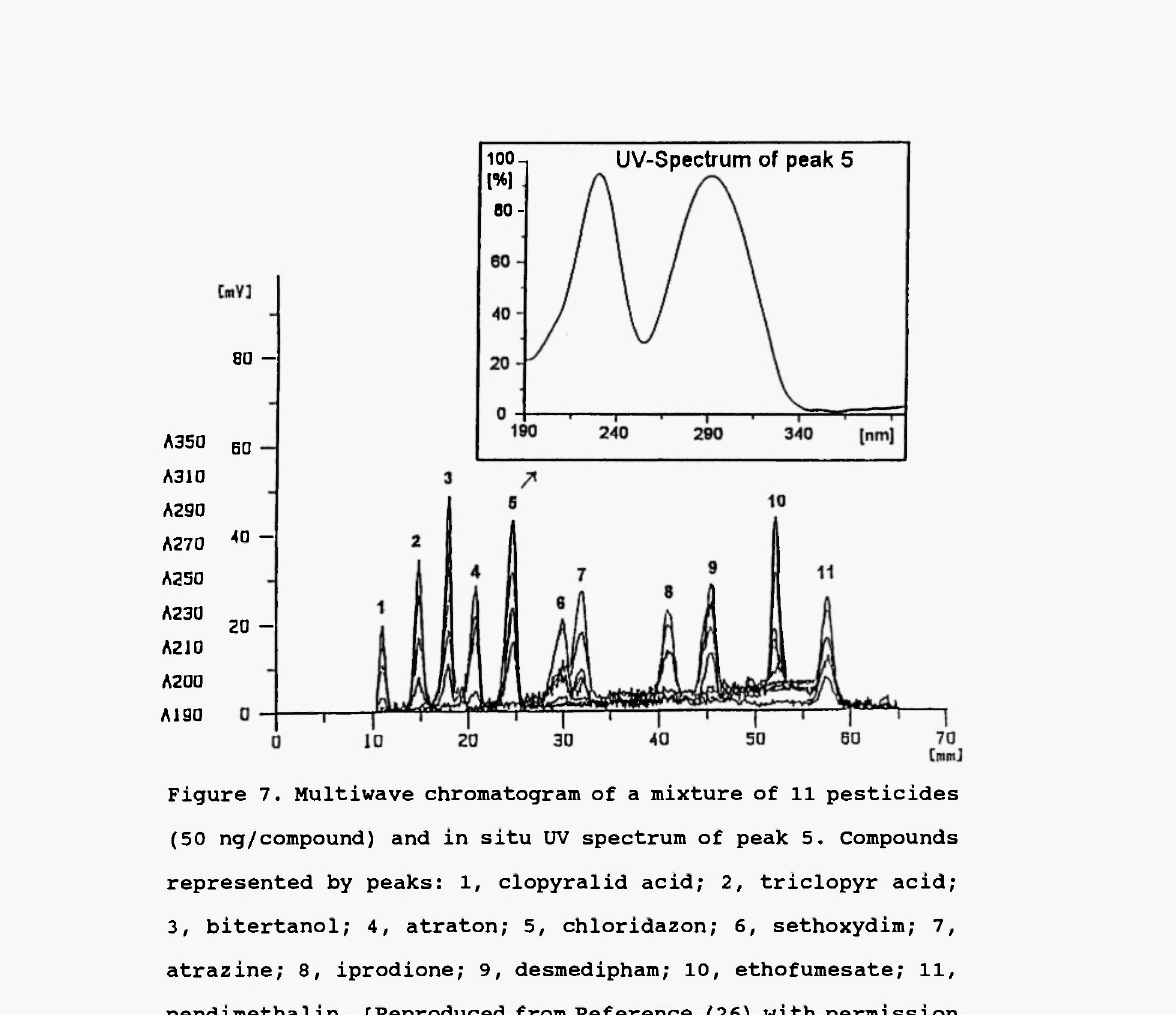
Figure 7. Multiwave chromatogram of a mixture of 11 pesticides (50 ng/compound) and in situ UV spectrum of peak 5. Compounds represented by peaks: 1, clopyralid acid; 2, triclopyr acid; 3, bitertanol; 4, atraton; 5, chloridazon; 6, sethoxydim; 7, atrazine; 8, iprodione; 9, desmedipham; 10, ethofumesate; 11, pendimethalin. [Reproduced from Reference (26) with permission of the American Chemical